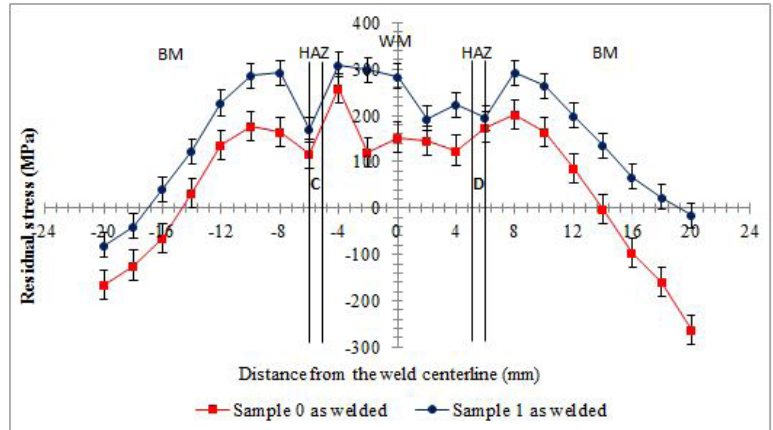
Figure 6. Comparative values of the residual stresses between samples 0 and 1as welded. Solid lines indicate the extent of the weld bead and HAZ.